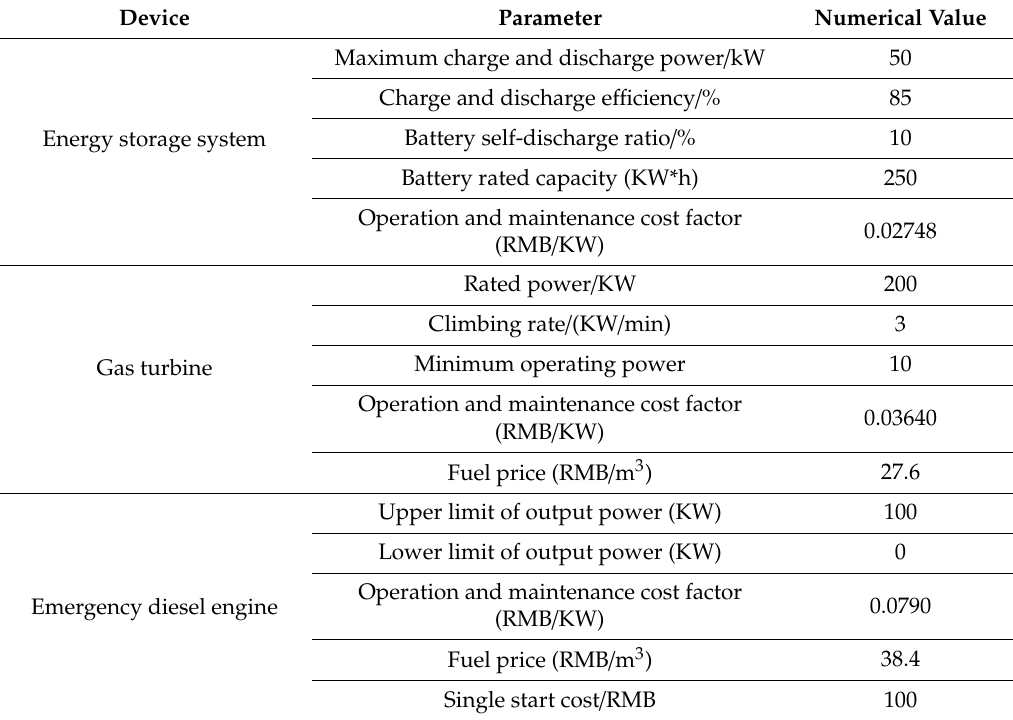
Table 3. Parameters of each unit of the o ff shore